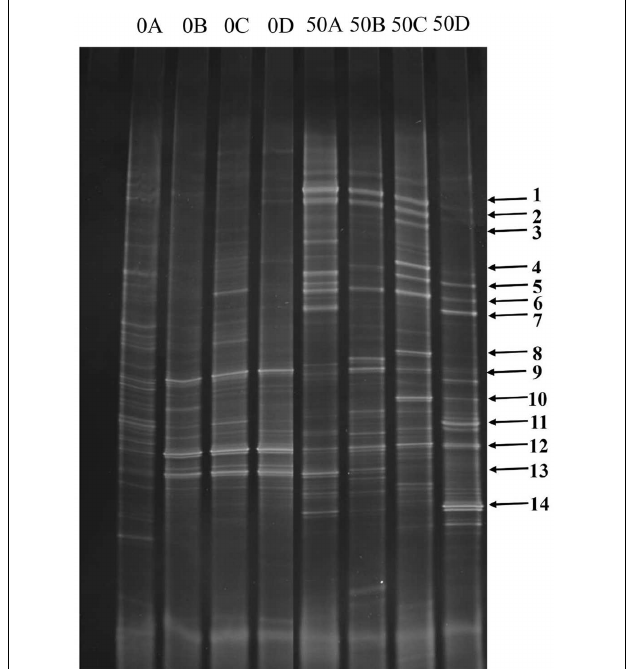
FIGURE 2 | Denaturing gradient gel electrophoresis (DGGE) profile of amplicons of V3 partitial sequence of bacterial 16S rDNA from BAC samples before phenol acclimation (0A, 0B, 0C, and 0D) and from the final enrichment cultures (50A, 50B, 50C, and 50D).